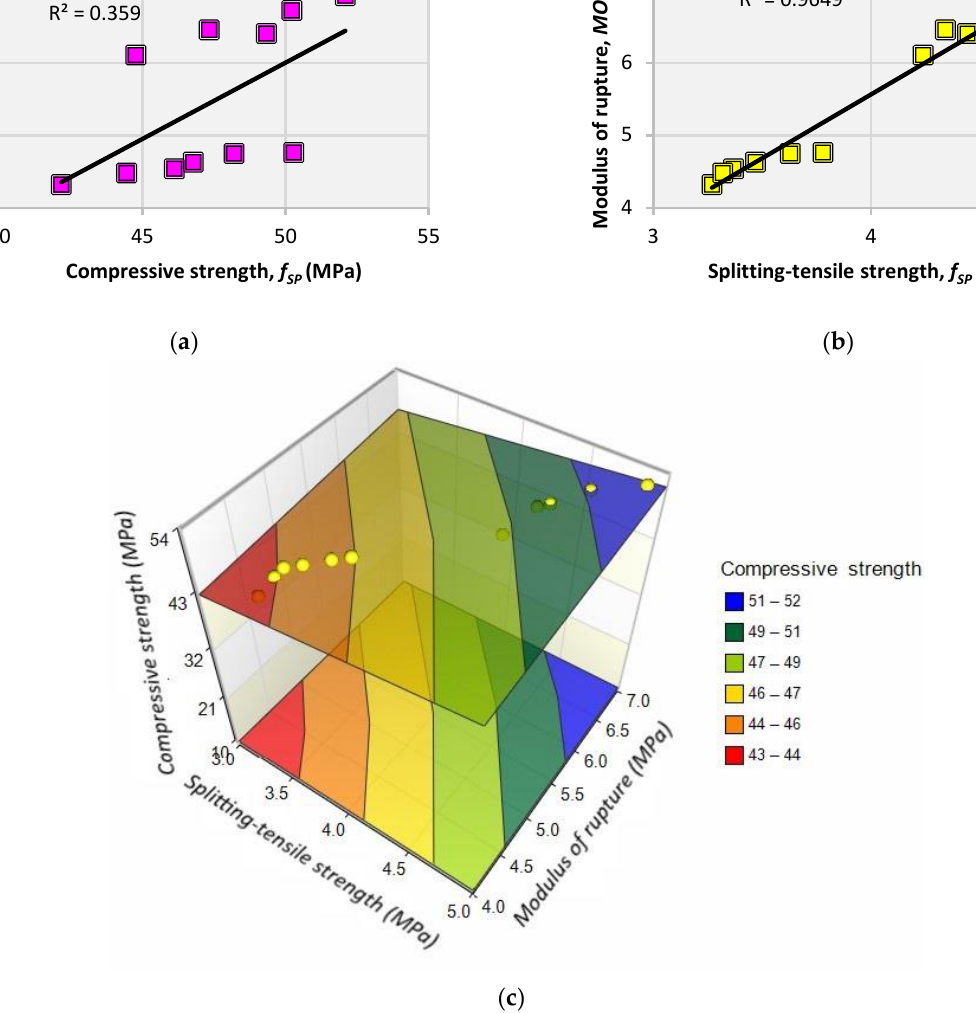
Figure 17. Correlation between ( a ) MOR and f CS ; ( b ) MOR and f SP ; and ( c ) MOR, f SP , and f CS.